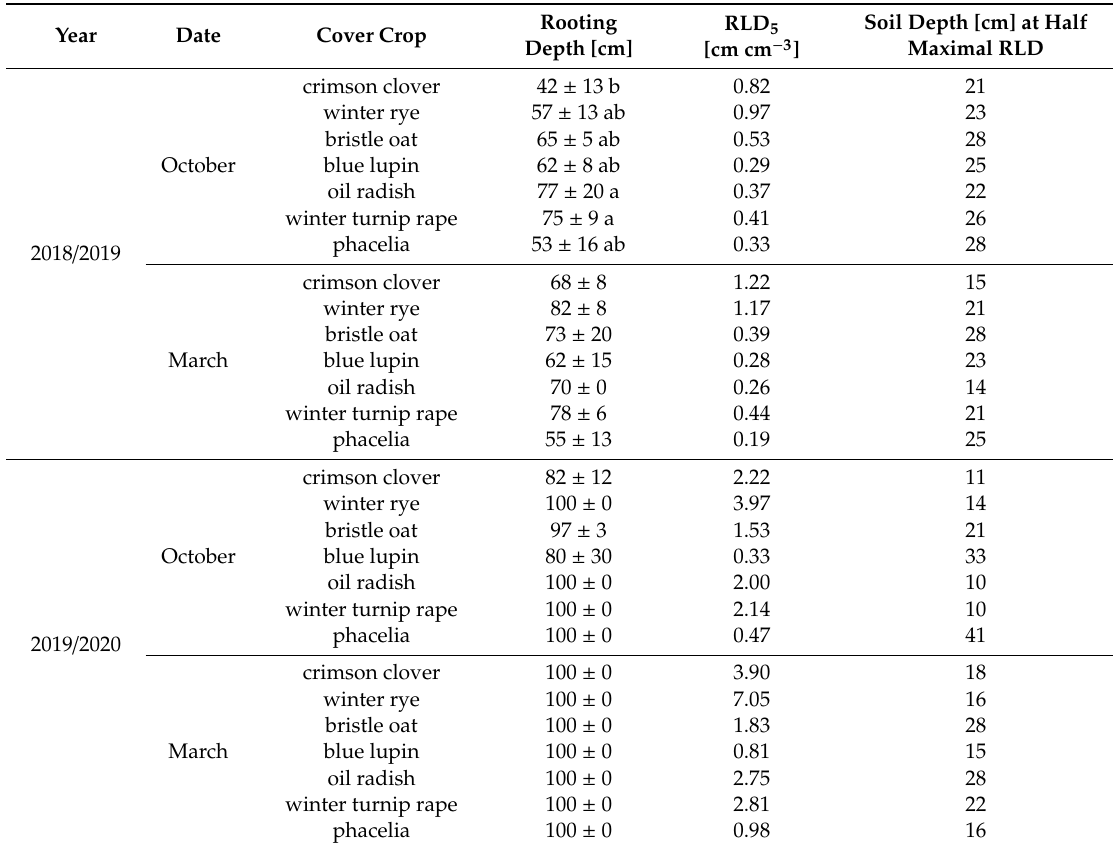
Table 4. Mean values ± standard deviation ( n = 3) of rooting depth [cm], estimated RLD [cm cm − 3 ] at 5 cm depth (RLD 5 ), and estimated depth [cm] at half maximal RLD from a three-parameter logistic regression of root length density depending on soil depth for di ff erent cover crops before (October) and after winter (March) in two seasons (2018 / 2019 and 2019 / 2020). Di ff erent letters indicate significant di ff erences ( α = 0.05) for rooting depth within one